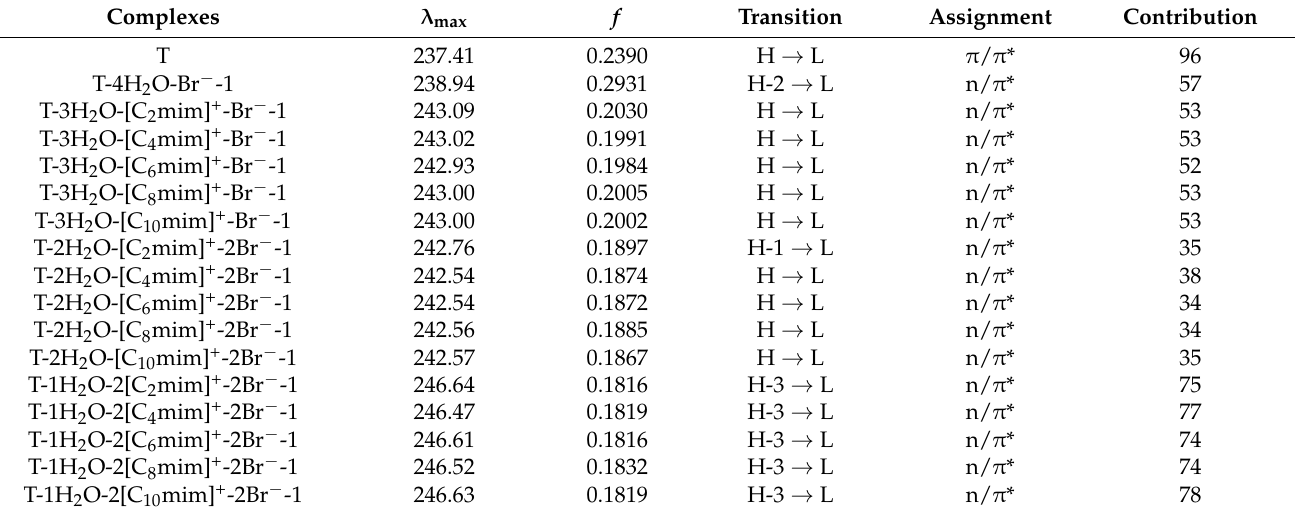
Table 1. TD-DFT calculated absorption maxima wavenumber (l max , nm), oscillator strength ( f ), transition electronic orbitals, transition assignment, and the corresponding main contributions (%) to the absorption maxima located within 220–280 nm for the microhydrates, T-4H 2 O-Br − -1, T-3H 2